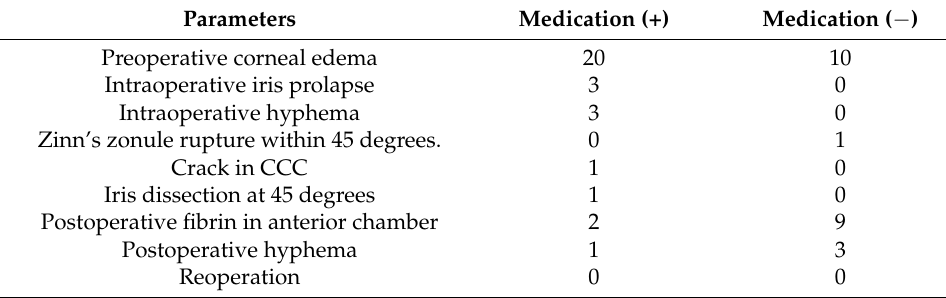
Table 3. Summary of surgical